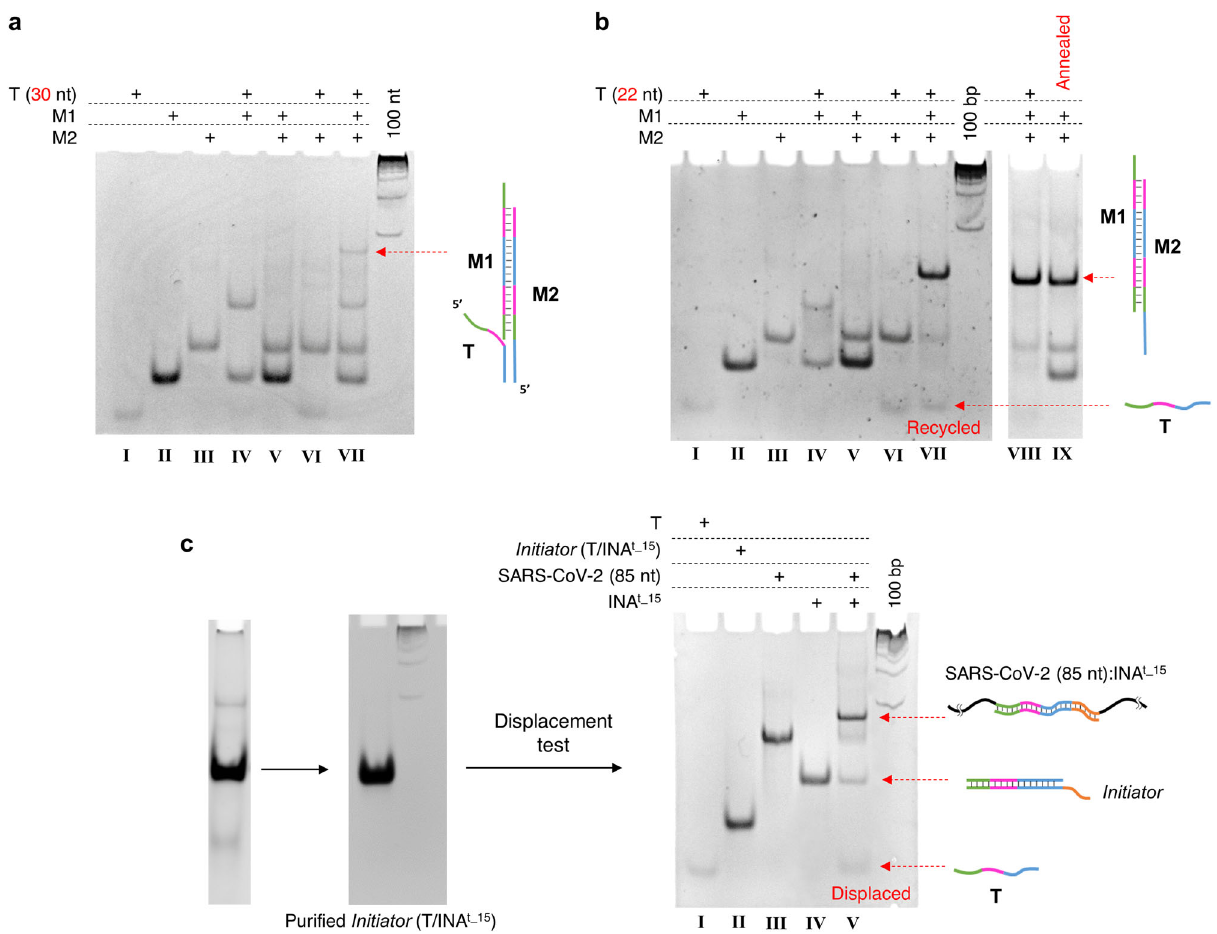
Fig. 2 Structure analysis of the designed probes. PAGE (12% TBM) analysis of a , ampli fi cation and b , displacement parts of the NISDA assay for N gene. a , b Investigating the role of Template length on the occurrence of the cascade reaction (ampli fi cation); decreasing the Template length from 30 to 22 nt resulted in disappearing of the unwanted bands and emergence of a new bands corresponding to the target M1:M2 duplex and recycling of the Template. c Typical gel image of the Initiator (T/INA t_15 ) before and after the PAGE puri fi cation together with the PAGE analysis on the displacement of Template by mimic SARS-CoV-2 (85 nt) strand. T denotes for Template. All the molecular weight markers are 100 bp. Each experiment was repeated at least two times